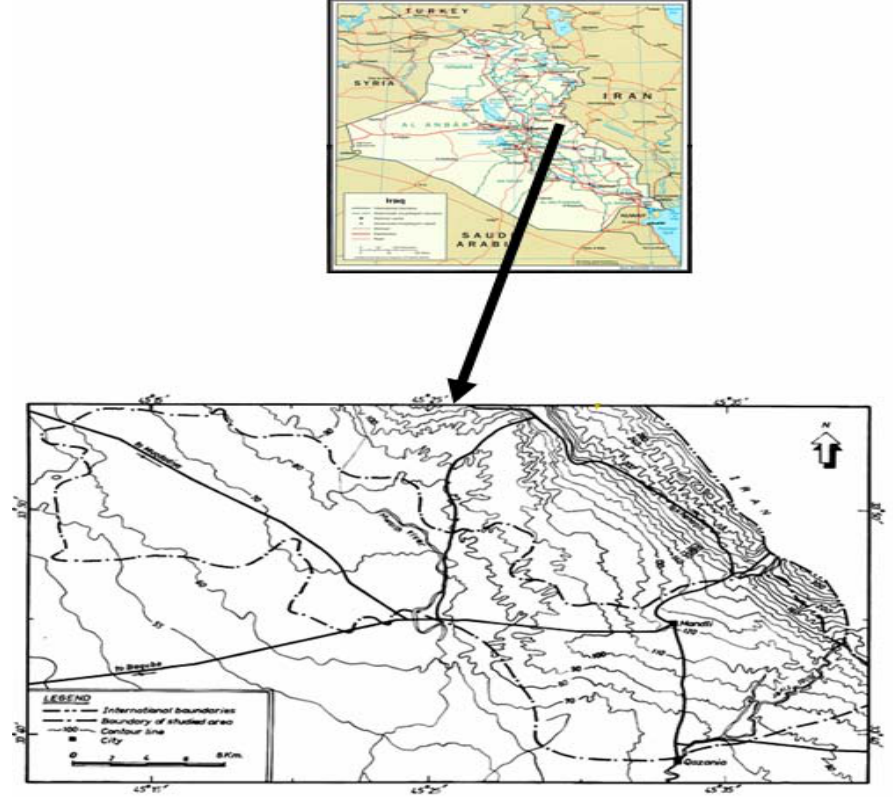
Fig.1: Map of Iraq shows the area of